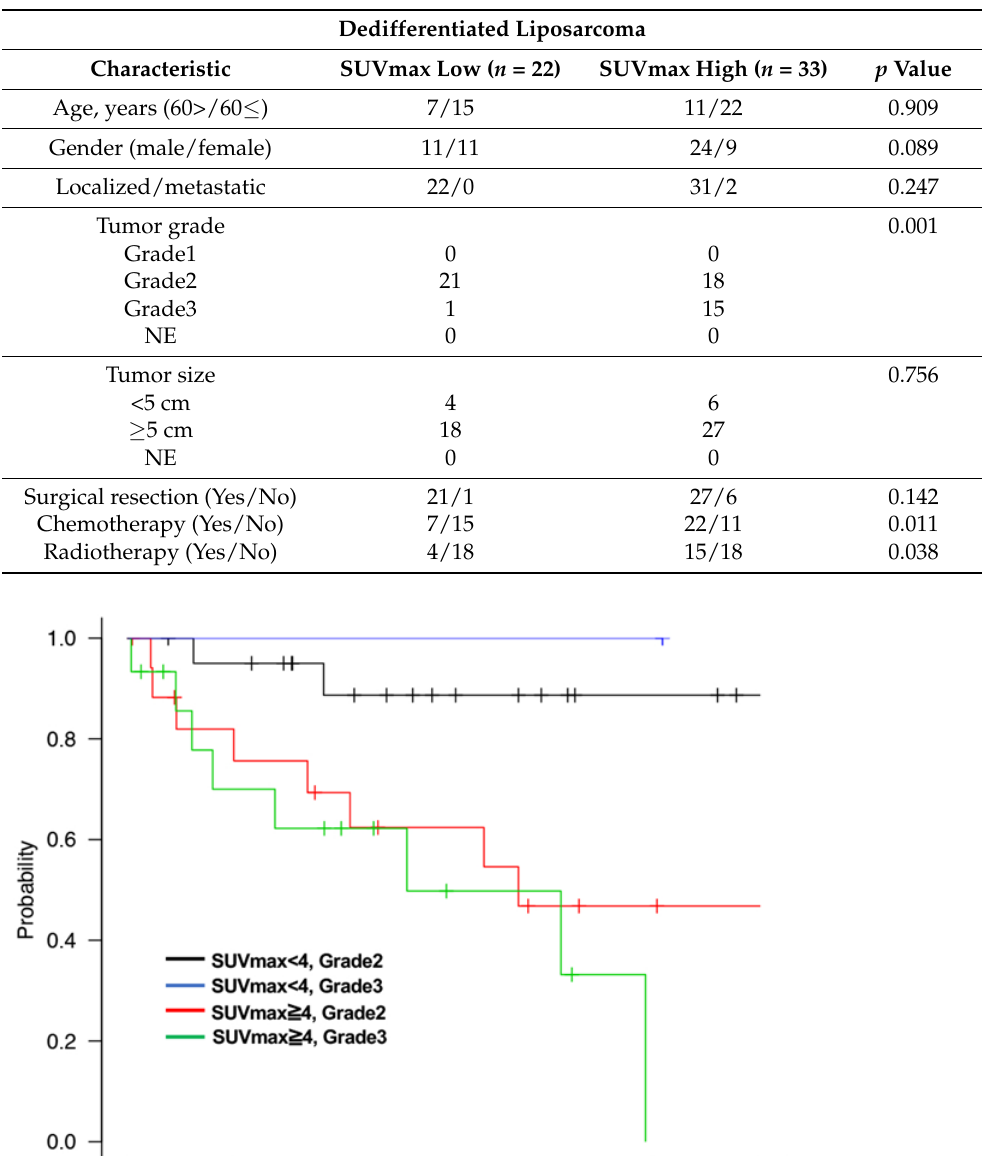
Table 8. Clinicopathologic and treatment characteristics between SUVmax low and SUVmax high in DDLPS.